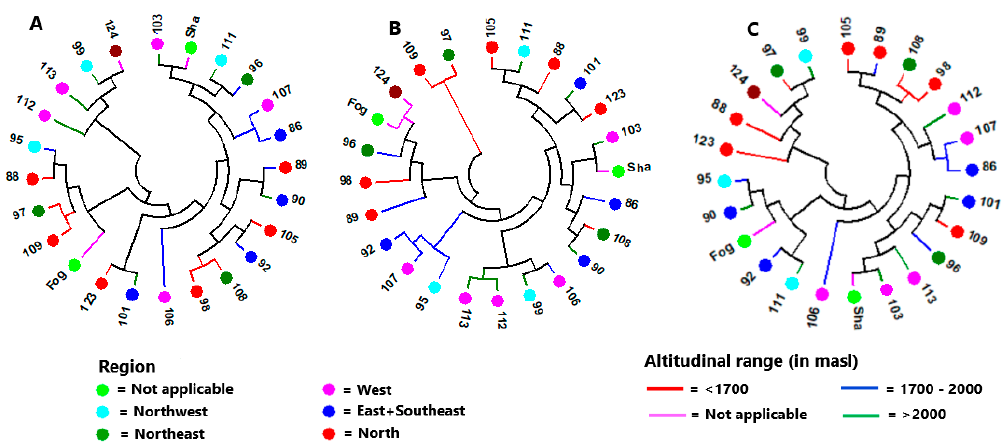
Figure 4. Neighbor-joining tree of the 24 accessions generated based on ( A ) all loci, ( B ) loci with a minor allele frequency of < 0.3, and ( C ) loci with a minor allele frequency of ≥ 0.3 using evolutionary distances computed by the Tajima-Nei method [53]. The accession names are given without the two initial letters (NG) for 22 of the 24 accessions, and “Fog” and “Sha” represent Fogera and Shambu, respectively. Accessions represented by the same shape and color belong to the same region, and accessions represented with the same color tree-line belong to the same altitudinal range.